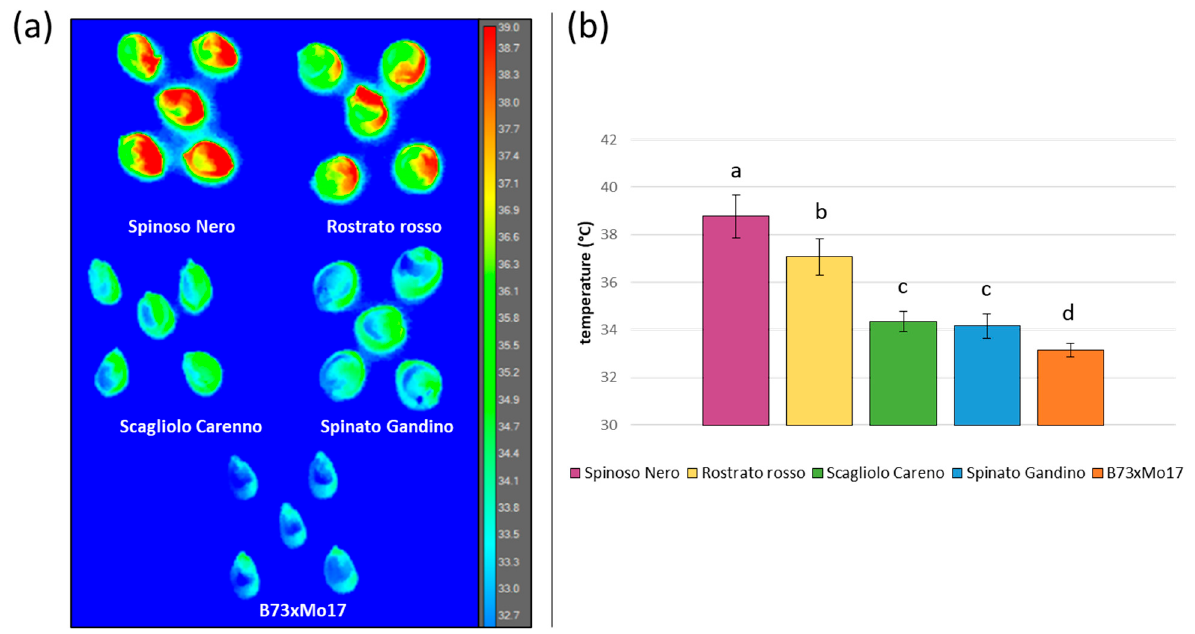
Figure 9. ( a ) Representative image of the seed temperature acquired with the thermographic camera (FLIR T650sc). ( b ) Seed temperature of the Italian traditional varieties and B73/Mo17 (control). Statistical analysis was performed using ANOVA test ( p < 0.05) and Tukey test.